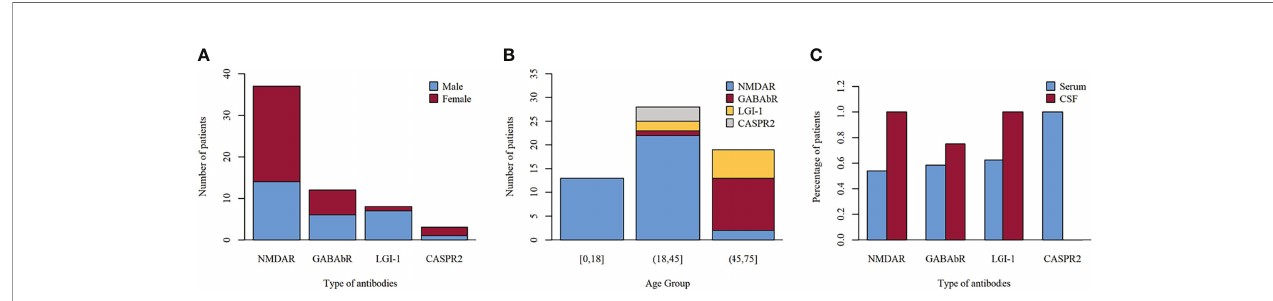
FIGURE 2 | Frequency of distributions of sex (A) , age (B) , and antibodies (C) among subtypes of autoimmune